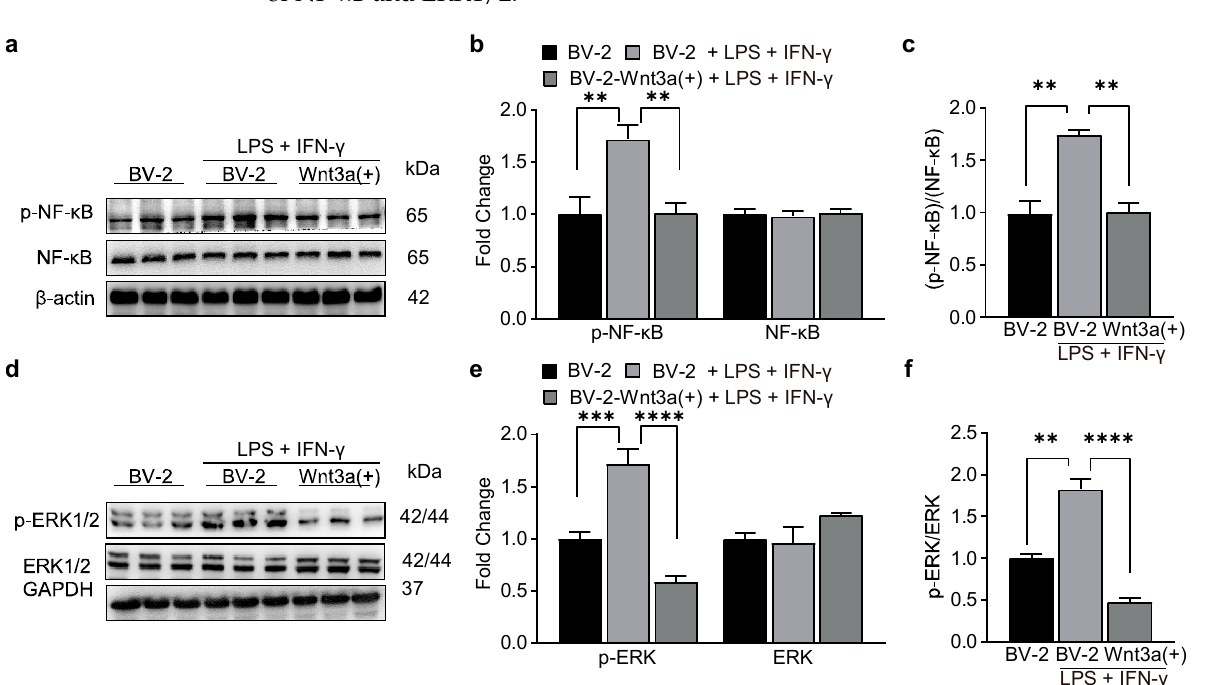
Figure 5. Wnt3a inhibited LPS/IFN- γ -induced activation of NF- κ B and ERK. Western blot showing expression of p-NF- κ B and NF- κ B in BV-2 cells after LPS/IFN- γ stimulation. ( a ) Representative bands. ( b ) Data summary. Two-way ANOVA, ** p = 0.0010, ** p = 0.0012, n = 3. ( c ) The ratio of phosphorylation NF- κ B to total NF- κ B. One-way ANOVA, F (2, 6) = 20.72, ** p = 0.0032, ** p = 0.0036, n = 3. Western blot showing expression of p-ERK1/2 and ERK1/2 in BV-2 cells after LPS/IFN- γ stimulation. ( d ) Representative bands. ( e ) Data summary. Two-way ANOVA, *** p = 0.0004, **** p < 0.0001, n = 3. ( f ) The ratio of phosphorylation ERK1/2 to total ERK1/2. One-way ANOVA, F (2, 6) = 66.36, ** p = 0.0011, **** p < 0.0001, n = 3.